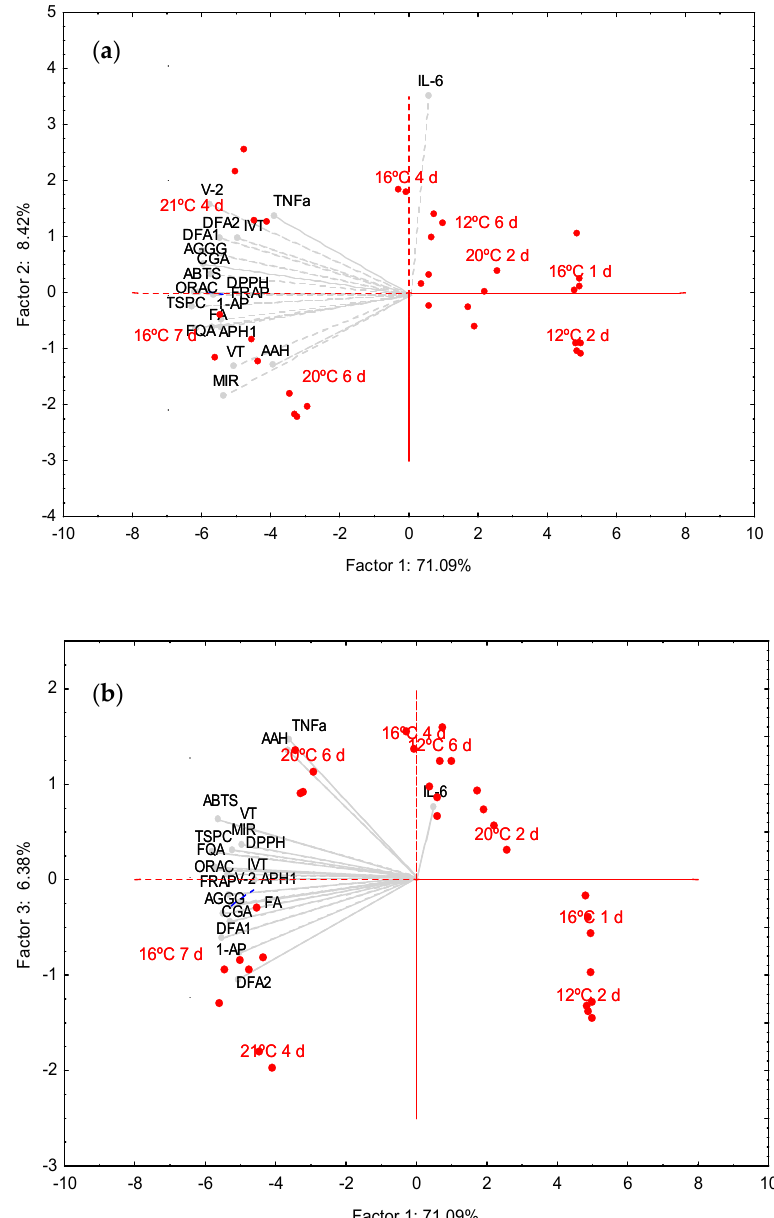
Figure 2. Bi-plots of PCA. Factor 1 vs. Factor 2 ( a ) and Factor 1 vs. Factor 3 ( b ) separates the germination experiments based on phenolic composition and bioactivity (antioxidant and anti-inflammatory properties) of wheat. Abbreviations: 2,2’-azino-bis(3-ethylbenzothiazoline-6-sulfonicacid)(ABTS);1-acetoxypinoresinol(1-AP); apigenin-6- C -arabinoside-8-C-hexoside (AAH); apigenin-6- C -galactosyl-8- C -glucosyl- O